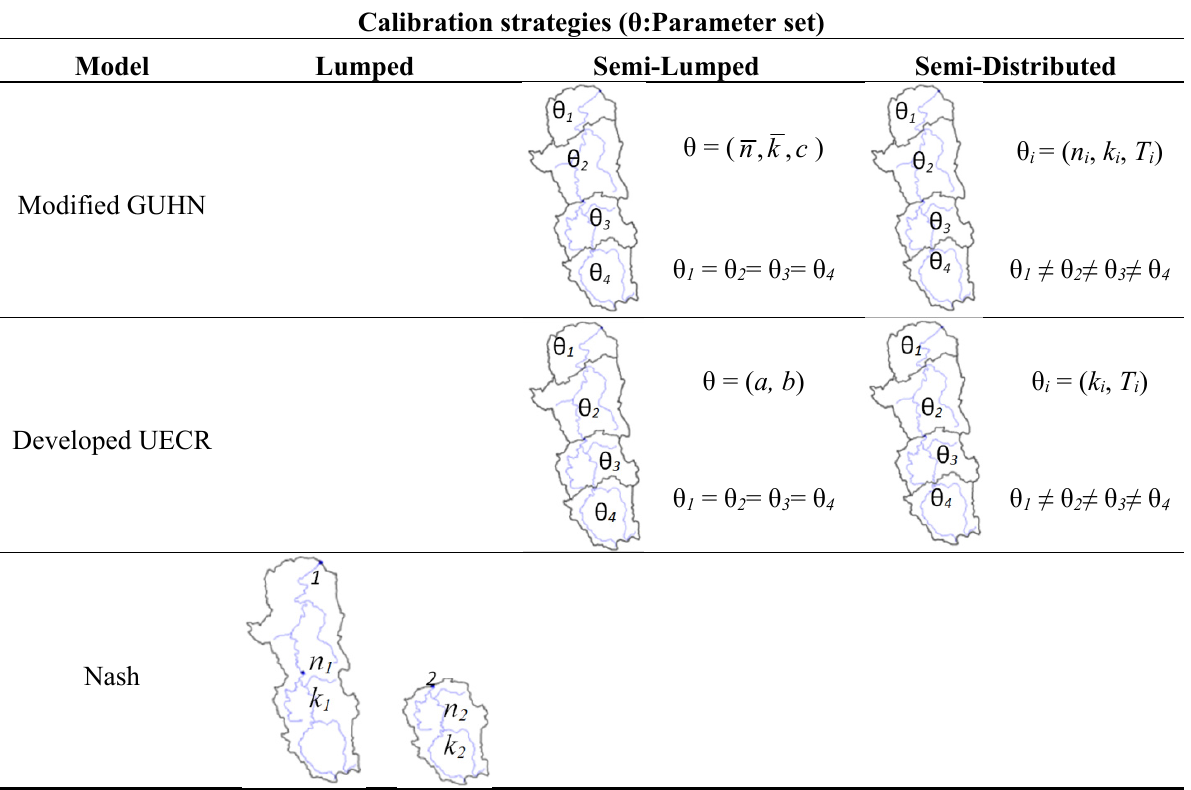
Table 4. Schematics of three different calibration strategies (adapted from Ajami et al.